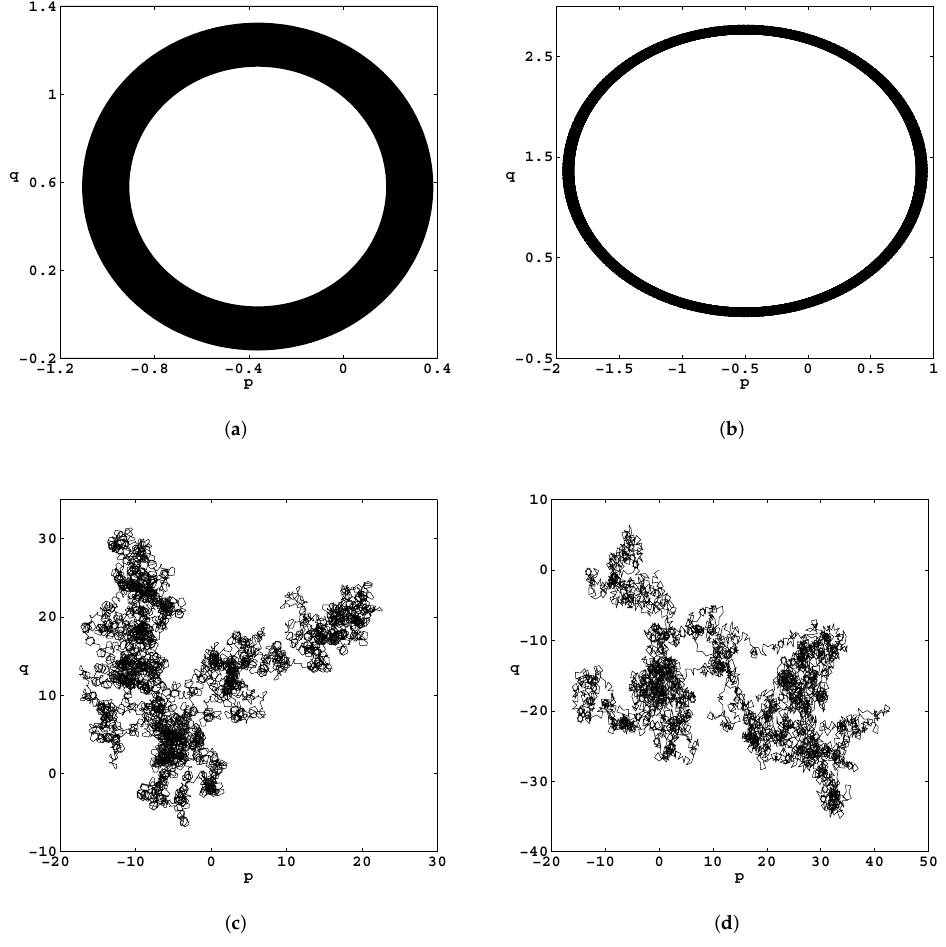
Figure 3. The 0-1 test results. Variables q − p for: ( a ) logistic map only with µ = 3.50 yielded K = 0.0015, ( b ) sequence of 7th bits from logistic map with µ = 3.50 yielded K = 0.0025, ( c ) logistic map only with µ = 3.99 yielded K = 0.9982 and ( d ) sequence of 7th bits from logistic map with µ = 3.99 yielded K =